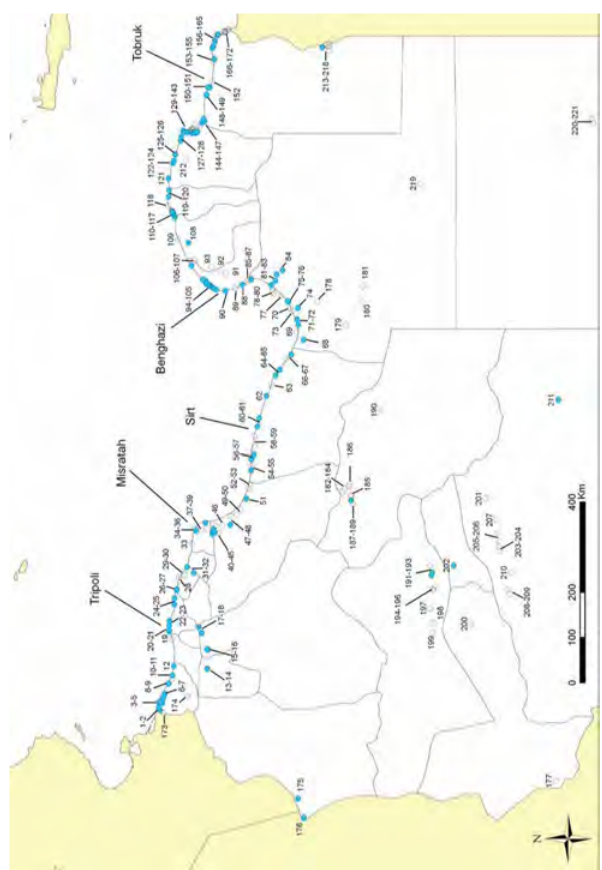
Figure 5. Atlas Map of Libyan wetlands.[5]. p40